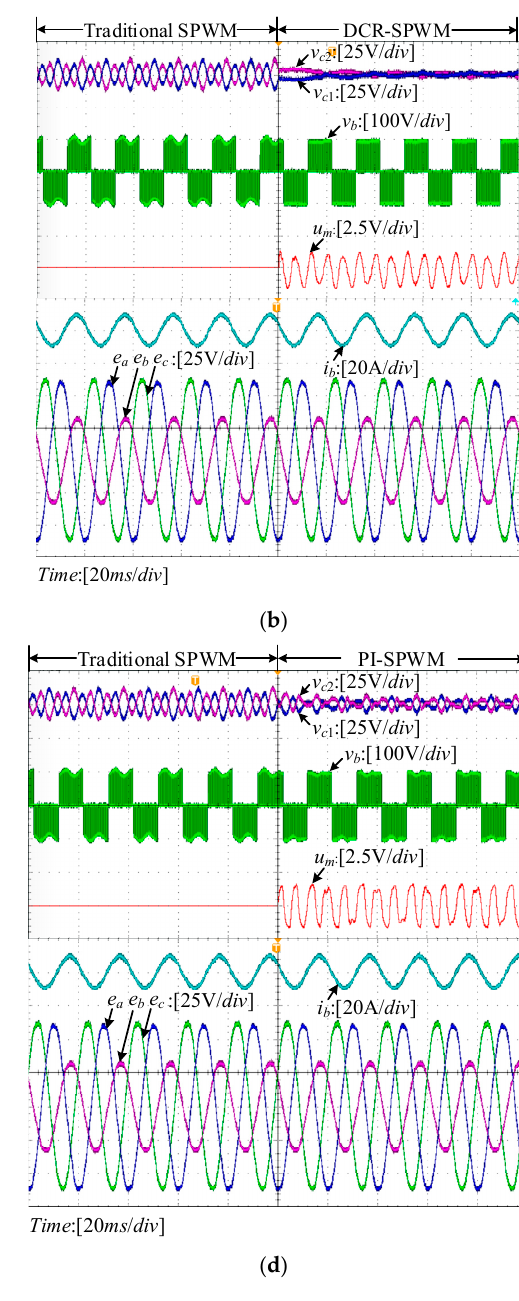
Figure 12. Experimental waveforms under different λ conditions: ( a ) DCR-SPWM φ ui = 0, λ = 0.15, v c 1avg − v c 2avg = 0; ( b ) DCR-SPWM φ ui = 0, λ = 0.2, v c 1avg − v c 2avg = 0; ( c ) PI-SPWM φ ui = 0, λ = 0.15, v c 1avg − v c 2avg = 0; ( d ) PI-SPWM φ ui = 0, λ = 0.2, v c 1avg − v c 2avg = 0.